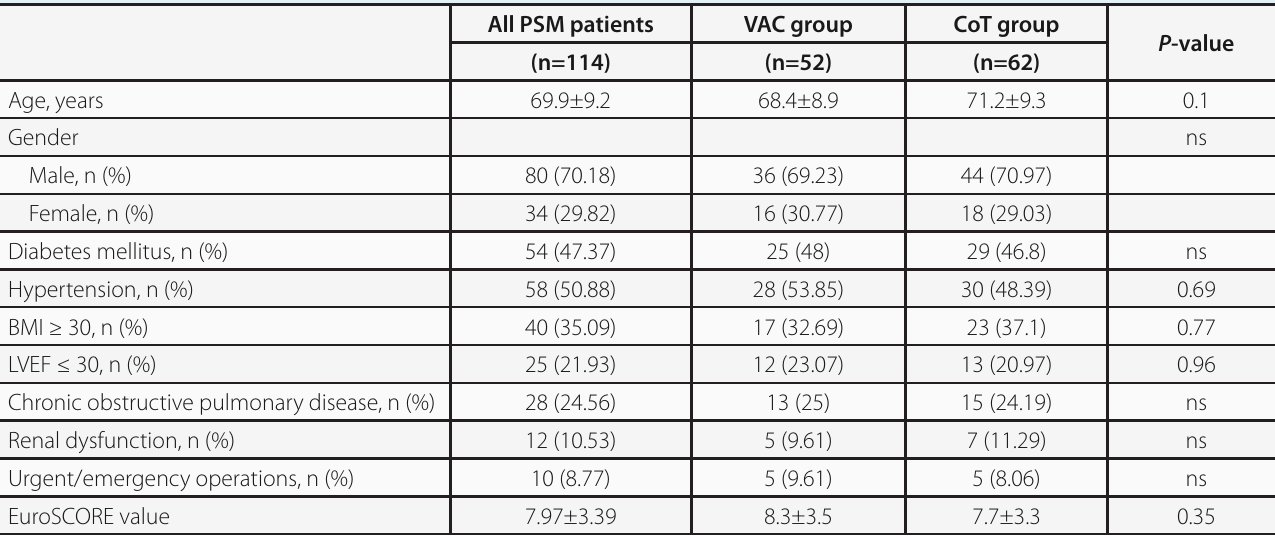
Table 1. Baseline characteristics of the study population.